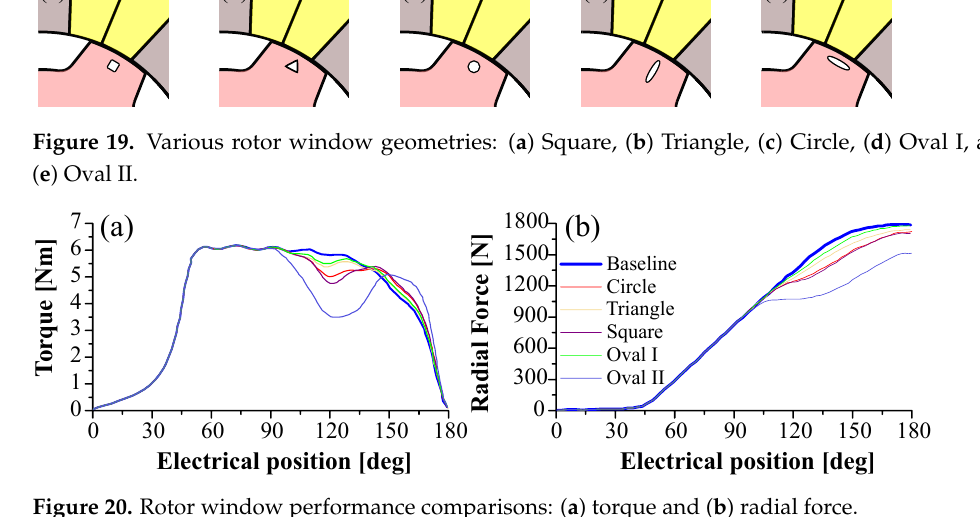
Figure 20. Rotor window performance comparisons: ( a ) torque and ( b ) radial force. Table 10. Performance ratio comparison for various rotor window shapes. Window Shape